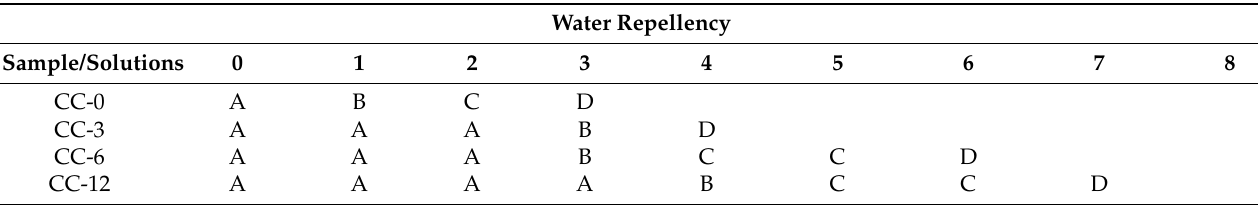
Table 4. Water repellency rating values of uncoated and HMDSO plasma polymerised coated leather samples.